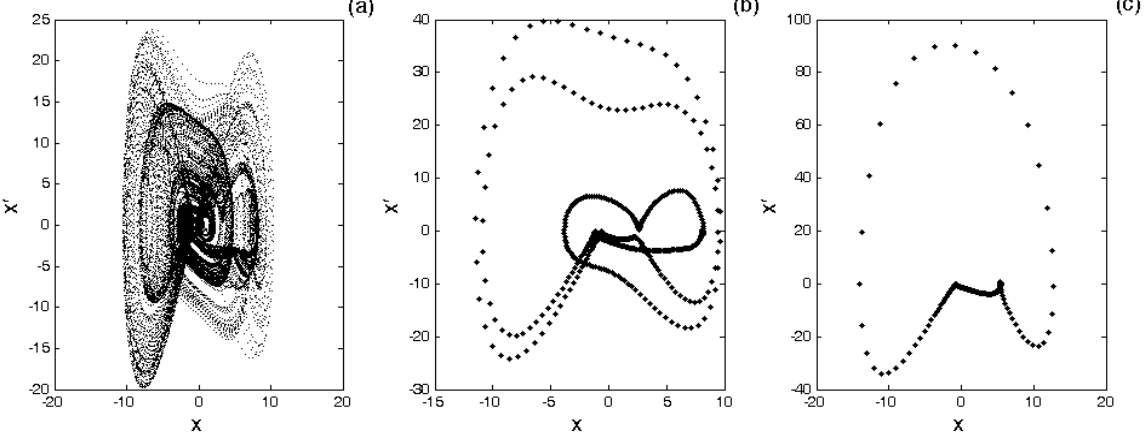
Fig. 11. Phase plane portraits on the responses of coupling system with different squeeze film damping ratio: (a) β = 0 . 04 ; (b) β = 0 . 1 ; (c) β = 0 . 2